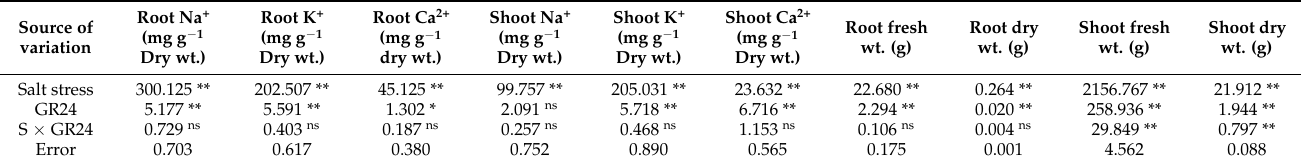
Table 2. Analysis of variance (ANOVA) for different mineral ions and plant biomass characteristics of ornamental sunflower with various GR24 levels (0, 0.001, 0.01 and 0.1 mg L − 1 ) under saline and non-saline